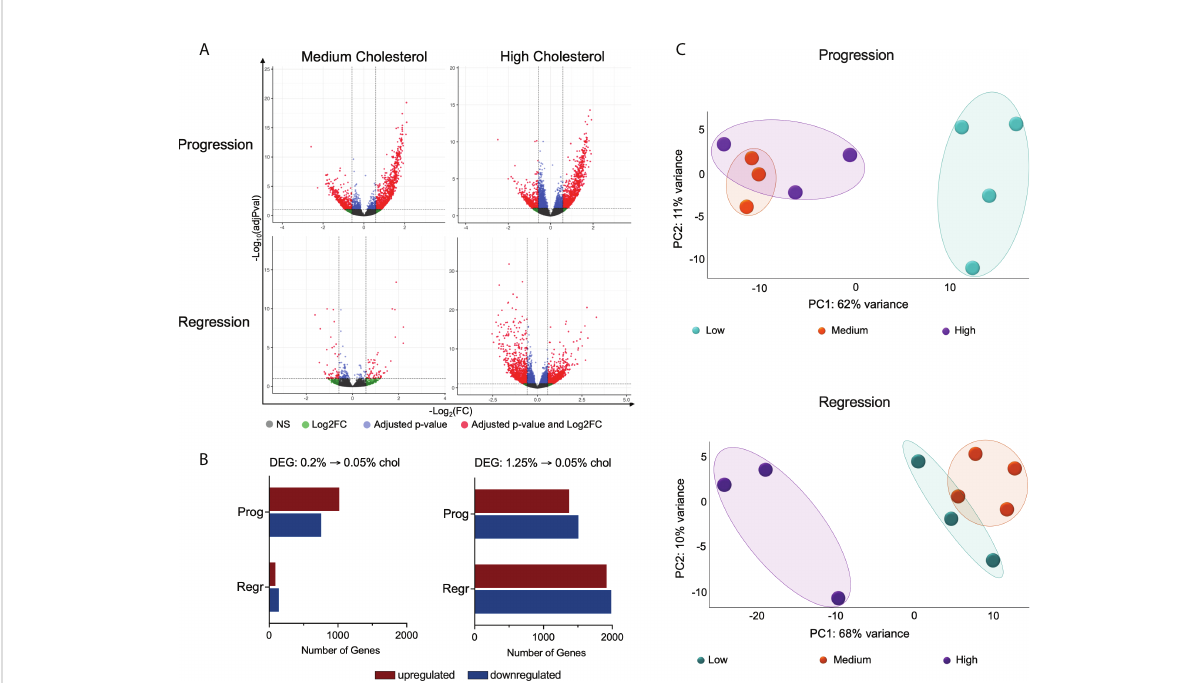
FIGURE 2 High cholesterol intake changes the global gene expression of hepatic macrophages. (A) Volcano plots show the hepatic macrophages ’ differentially expressed genes (DEGs) in the different dietary groups, emphasizing the cholesterol effect. DEG lists were acquired by normalizing the transcriptome from the high and medium cholesterol groups using the age-matched low cholesterol group. (B) Comparing the medium to the low cholesterol group, we found 1,774 genes modi fi ed during the progression phase (1,019 up and 755 down) and 229 genes in the regression phase (90 up and 139 down). The comparison between the high to the low cholesterol group revealed 2,880 genes differentially expressed during the progression phase (1,373 up and 1,507 down), and 3,902 DE genes in the regression phase (1,918 up and 1,984 down). (C) PCA plots clearly show that during the progression phase, the medium cholesterol (n = 3) and the high cholesterol (n = 3) groups differed from the low cholesterol group (n = 4) and that after cholesterol reduction (regression phase), the medium cholesterol group (n = 4) became comparable to the low cholesterol group (n = 3), while the high cholesterol group (n = 3) maintain the original difference. NS, non-signi fi cant; Log2FC, log2-foldchange based on low cholesterol age-matched group; Prog, Progression phase; Regr, Regression